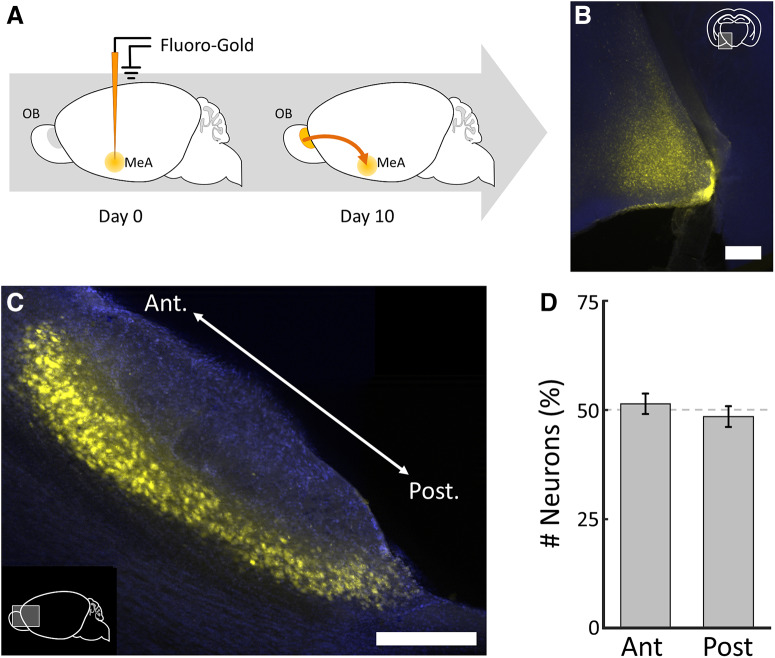
Classical retrograde tracing from the MeA to the AOB. A, Fluoro-Gold was iontophoretically injected into the MeA, and 10 d were allowed for retrograde transport of Fluoro-Gold from the MeA to the AOB. B, A Fluoro-Gold injection site demonstrates labeling in both the dorsal and ventral MeA. C, Retrogradely labeled projection neurons in the AOB mitral cell layer showing dense labeling in both the anterior and posterior AOB. D, Percentage of neurons located in the anterior versus posterior AOB. Scale bars, 250 μm.